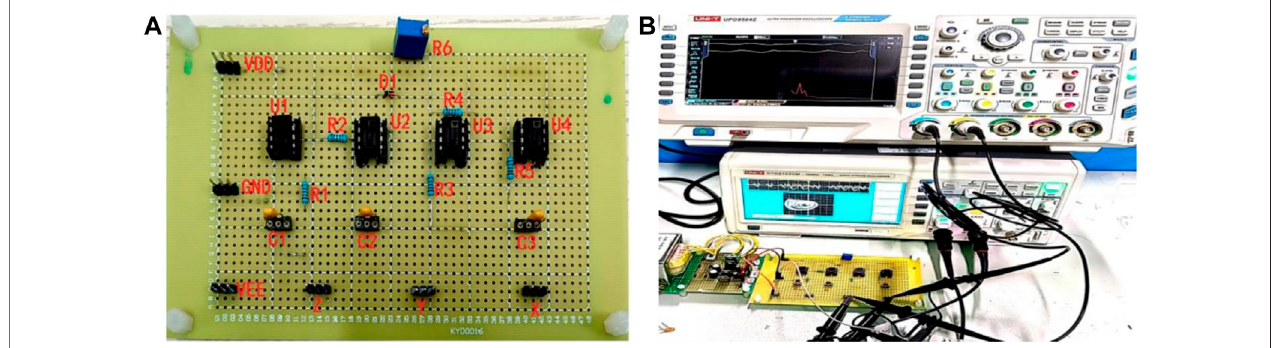
FIGURE 10 | VFOA circuit experimental test. (A) The experimental circuit board with AD711AN. (B) Actual experimental test with UNI-TUTD2102CM and UNI-T